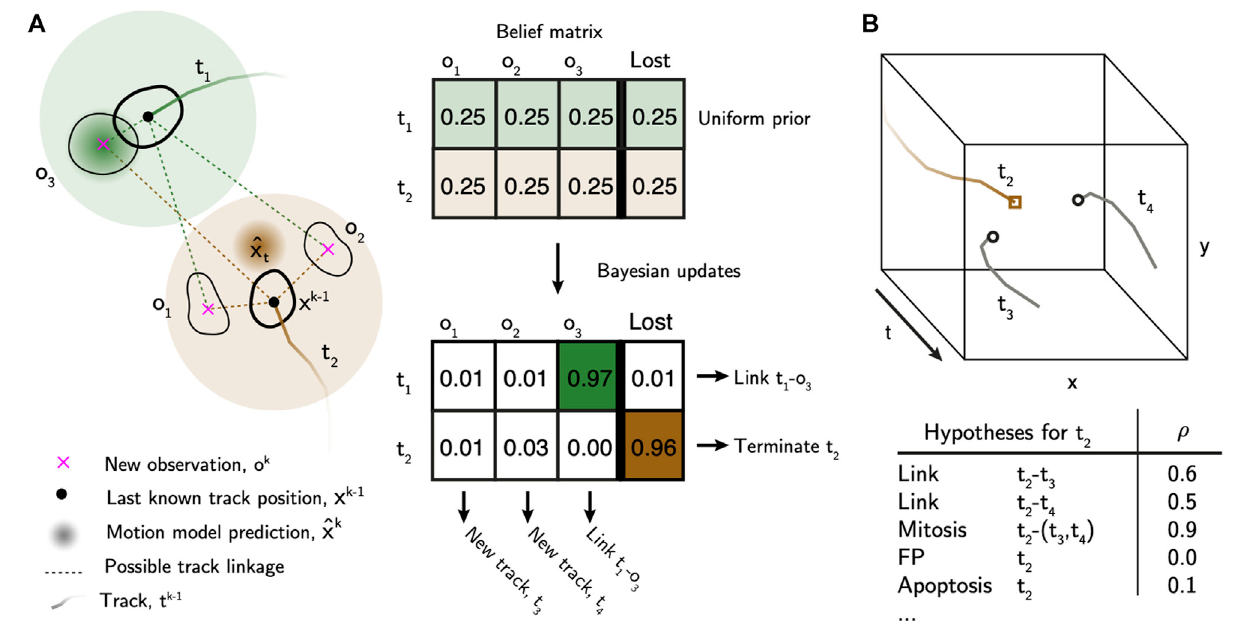
FIGURE 3 | Bayesian tracking approach overview. (A) Bayesian belief matrixwith uniform prior isconstructed for tracklet association. Using the localised and labelled cell observations, btrack uses Kalman fi lters to predict the future state of the cell (x ^ ) from previous observations. Each object appearing in the new frame has uniform prior probability of track association or loss. The belief matrix is an N x (M+1) matrix where N equals number of active tracks and M is the number of detected objects per fi eld of view.Bayesianupdatesareperformedusingthepredictedtrackpositionsandstateinformationtocalculatetheprobabilitythattracksareconsideredlost,ortobelinked toanobject.Objectswhicharenotassigned,initialisenewtracks.T1representsasimpleassociation,wherethepredictionmatchestheobservationO1.InT2thecelldivides, meaningthatthereisnosimpleassociation.NewtracksT3andT4areinitialised. (B) Globaltrackoptimisation.Ann-dimensionallocalsearchcreatesallpossiblehypotheses, eachwithanassociatedlikelihood,foreachtrackbasedonuserde fi nedparameters.SeveralhypothesesaregeneratedforTrackT2,asin (A) :possiblelinkagetoT3orT4,T2 undergoesmitosisgeneratingT3andT4,T2isafalsepositivetrackorthatT2undergoesapoptosis.Thelog-likelihoodofeachhypothesis( ρ )iscalculatedusingtheimageand motion features. These hypotheses are evaluated in a global optimisation step to generate the fi nal tracking results.